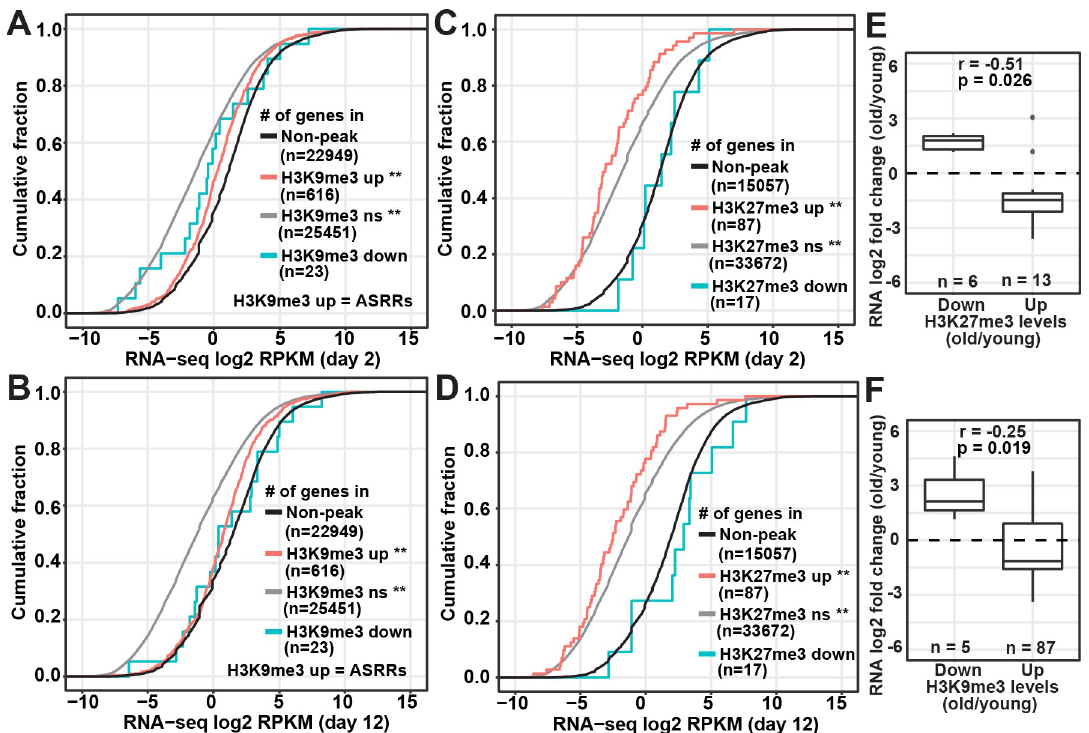
Fig 2. Anti-correlation between changes in repressive marks and gene expression. (A-D) Cumulative frequency plots of the normalized RNA read counts (log 2 RPKM) of genes associated with H3K9me3 (A and B) or H3K27me3 (C and D) peak regions versus genes in non-peak regions (black curves) in young (day 2) and old (day 12) germlineless glp-1(e2141) mutants. Repressive peak regions were divided into three groups based on age-dependent changes: significantly upregulated (up, red curves), significantly downregulated (down, cyan curves), and non-significant (ns, gray curves). Comparing to genes in the non-peak regions (black curves), genes associated with upregulated and non-significant repressive peak regions had significantly lower RNA expression levels ( �� , p- values of Kolmogorov–Smirnov test < 0.0001). The number of genes associated with a given set of peak regions is indicated in the parenthesis. Abbreviation: ASRRs, aging-specific repressive regions. (E and F) Box plots comparing age-dependent RNA expression fold change (log 2 ) of differentially expressed genes associated with significantly upregulated or downregulated H3K27me3 (E) or H3K9me3 (F) peaks. The numbers of differentially expressed genes (n) associated with individual groups of peak regions are indicated in the figures: 87 and 5 genes associated with the 578 upregulated and 17 downregulated H3K9me3 peaks, and 13 and 6 genes associated with the 59 upregulated and 7 downregulated H3K27me3 peaks, respectively. Pearson’s correlation coefficient (r) and p- value of the correlation between fold changes in RNA expression and histone modifications are indicated on the top of each